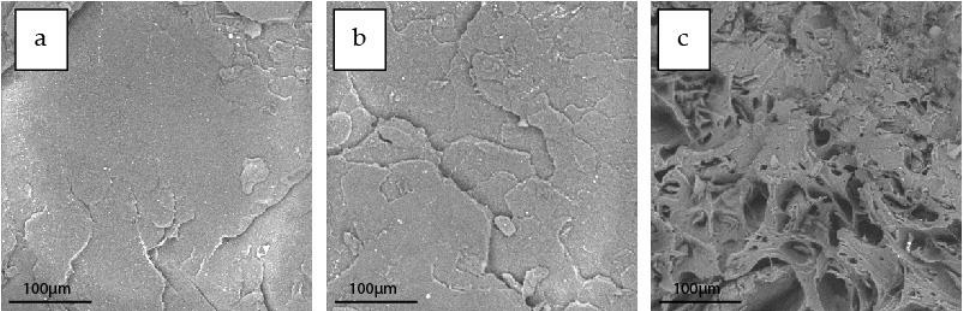
Figure 1. SEM cross-section images of the ( a ) PLA filament, ( b ) PLA/PHA filament and ( c ) PLA/PHA/wood fiber